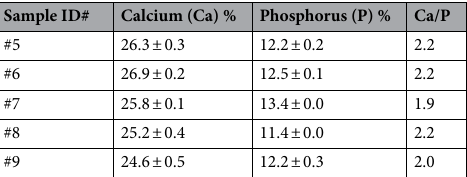
Table 2. Calcium (Ca) and phosphorus (P) contents measured in modern bearded vulture scats and the Ca/P